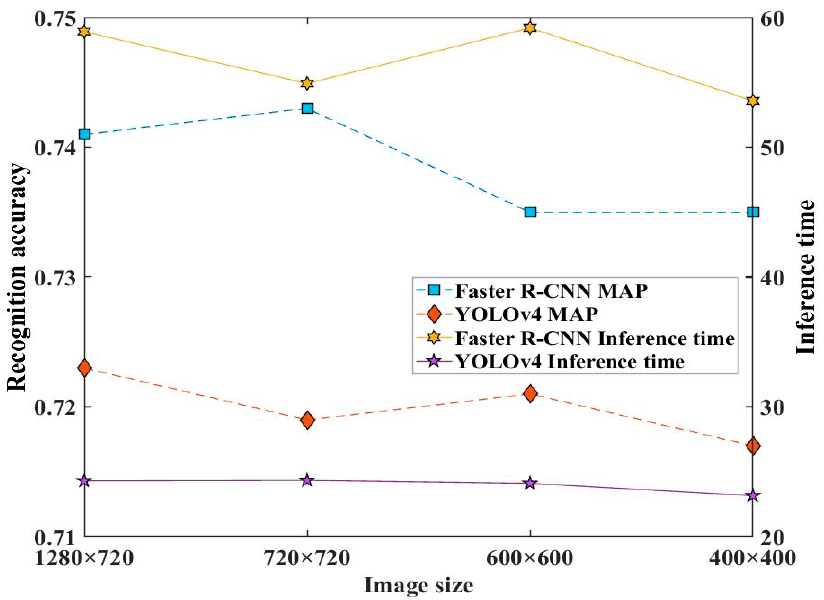
Figure 11. Effect of image size of developing datasets on the recognition accuracy and inference time of the two approach models.